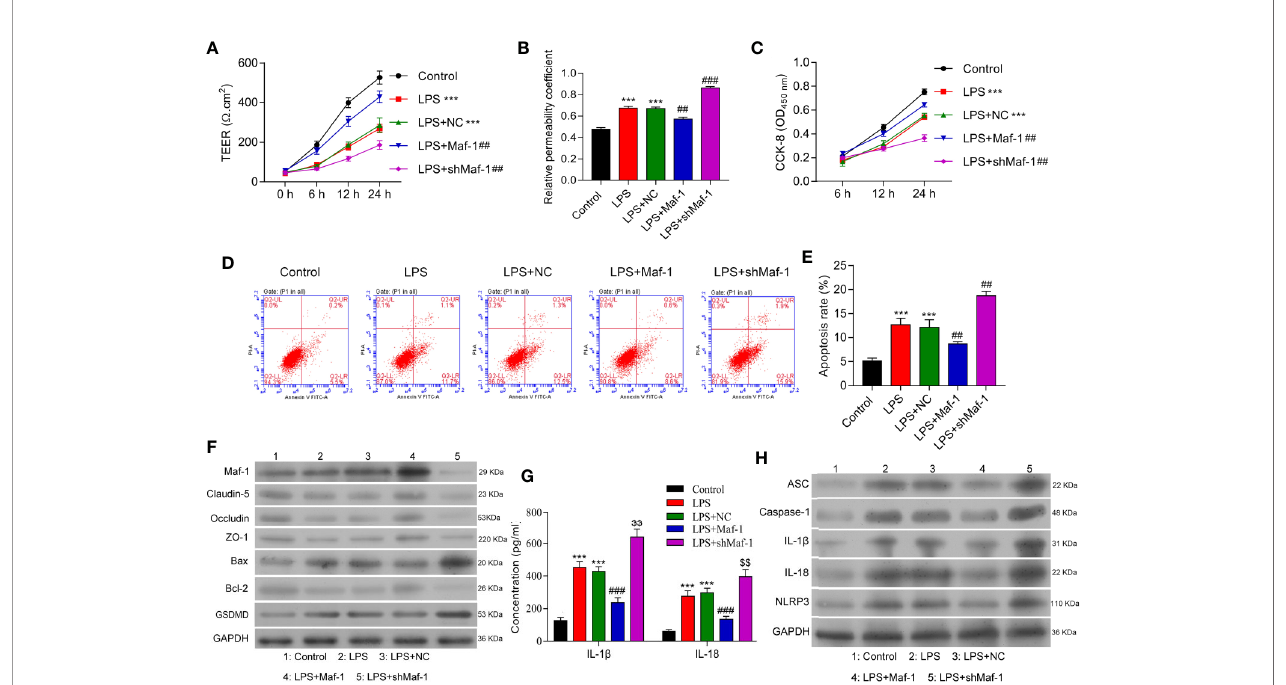
FIGURE 1 | Maf1 alleviated BBB disruption, neuro-apoptosis, and in fl ammation induced by LPS. BMECs were transfected with a control vector (NC), Maf1 or shMaf1 plasmid, followed by LPS stimulation; they were then co-cultured with astrocytes to establish an in vitro BBB model. (A) The TEER values of monolayer cells at 0, 6, 12, and 24 h were measured using a bioelectric impedance analyzer. (B) Trans-endothelial permeability assays were performed to assess the in vitro BBB integrity by using the diffusion of 10 kDa FITC-dextran method. The relative permeability coef fi cient was determined after Transwell experiments were conducted. (C) Cell viability was analyzed using the CCK-8 assay. (D) Representative images of Annexin V/PI double staining, and (E) measurements of apoptosis. (F) The levels of Maf1, Claudin-5, Occludin, ZO-1, Bax, Bcl-2, and GSDMD were determined by western blotting. GAPDH served as a loading control. (G) Cell-free conditioned culture medium was collected and analyzed by ELISA for IL-1 b and IL-18 levels. (H) Western blot analyses of pro-in fl ammatory cytokine (ASC, Caspas-1, IL-1 b , andIL-18) and NLRP3expression levels. Results are expressed as the mean value ± SD of data obtained from three separate experiments. *** p < 0.001, compared with Control; ## p < 0.01, compared with LPS +